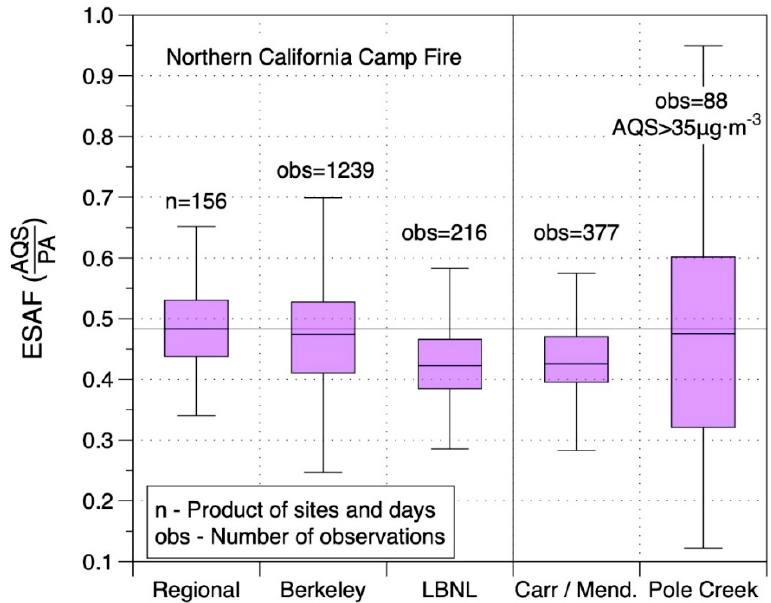
Figure 9. Event specific adjustment factors (ESAFs) calculated for PA-II monitors using data from three wildfire smoke events in 2018. The LBNL results are for indoor monitoring of infiltrated PM 2.5 in a lab with an estimated outdoor air exchange rate of 0.5 h − 1 .